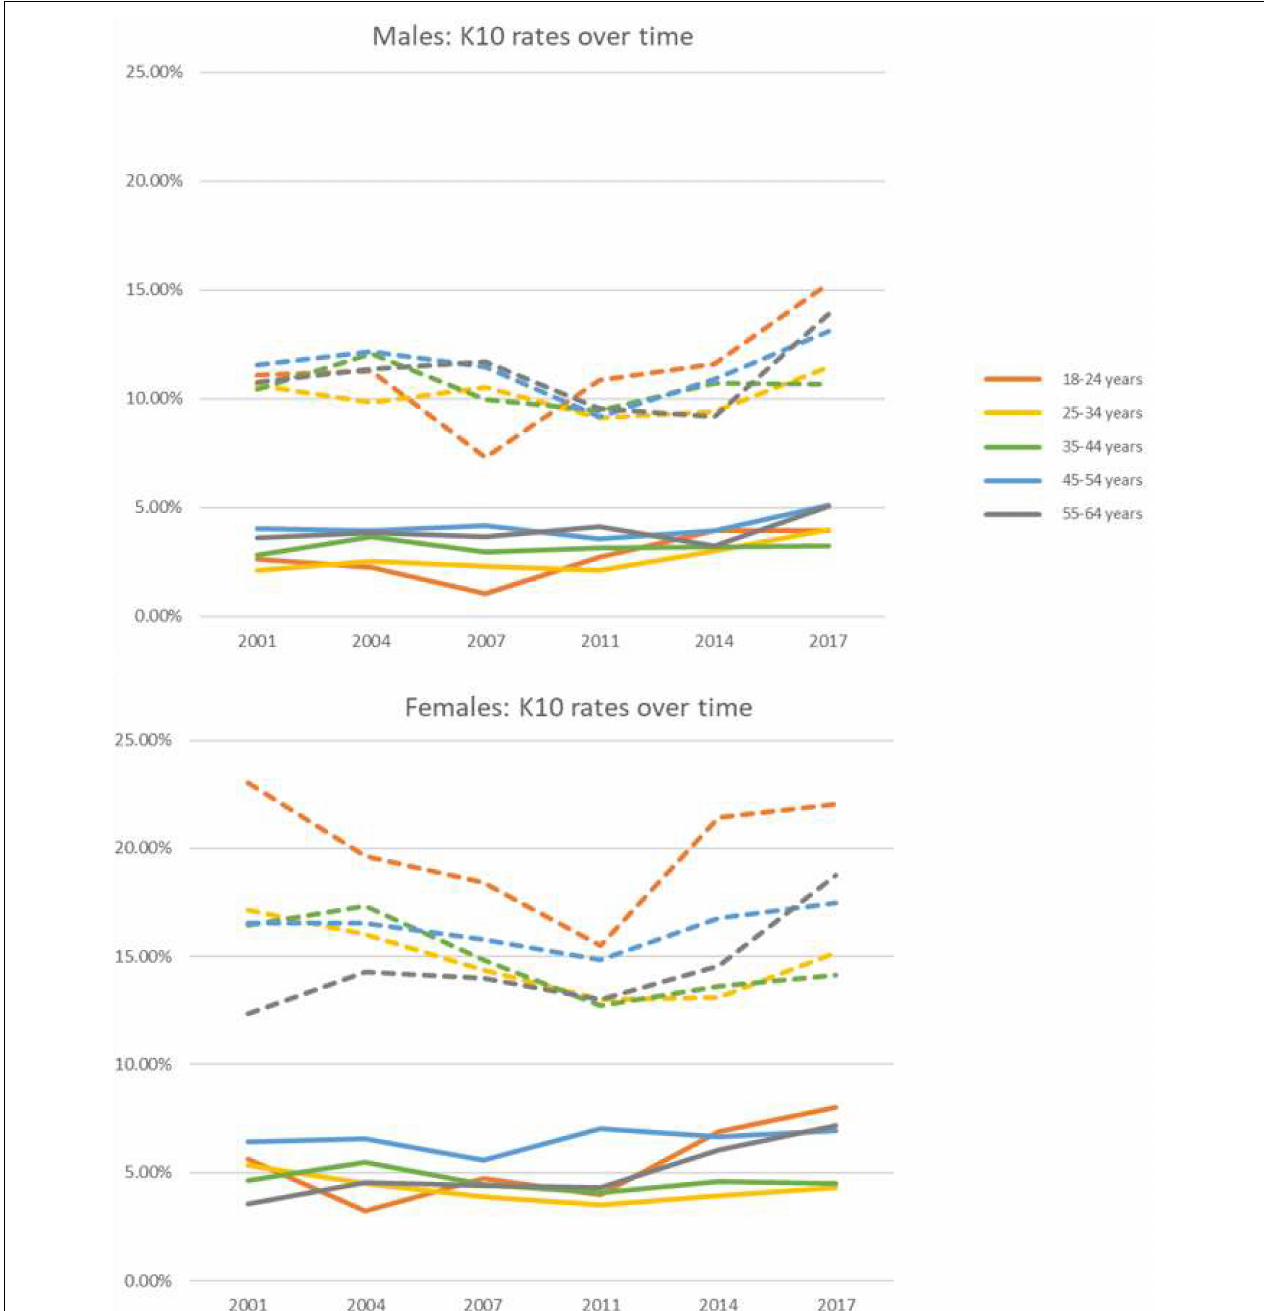
FIGURE 2 | By age-groups and sex, shown are the age-standardized prevalence of psychological distress (solid lines are the Very-high K10; and broken lines are the combined High/very-high K10). Standardized to 2001 Australian Census. Derived from a total of n = 78,204 survey participants aged 18–64 years. The 95% confidence intervals are given in Supplementary Table 2